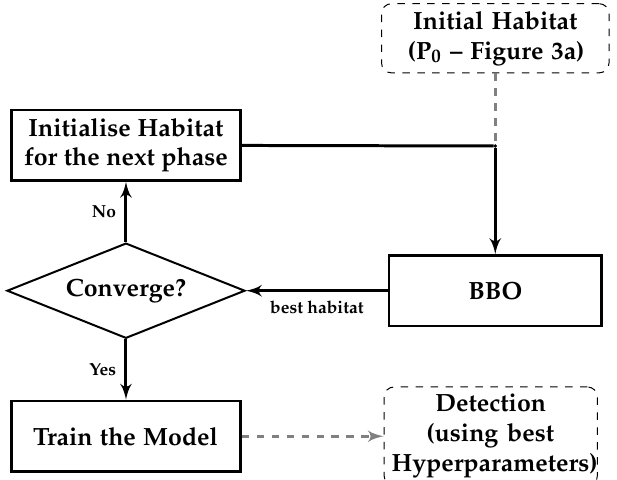
Figure 2. A schematic overview of the evolutionary